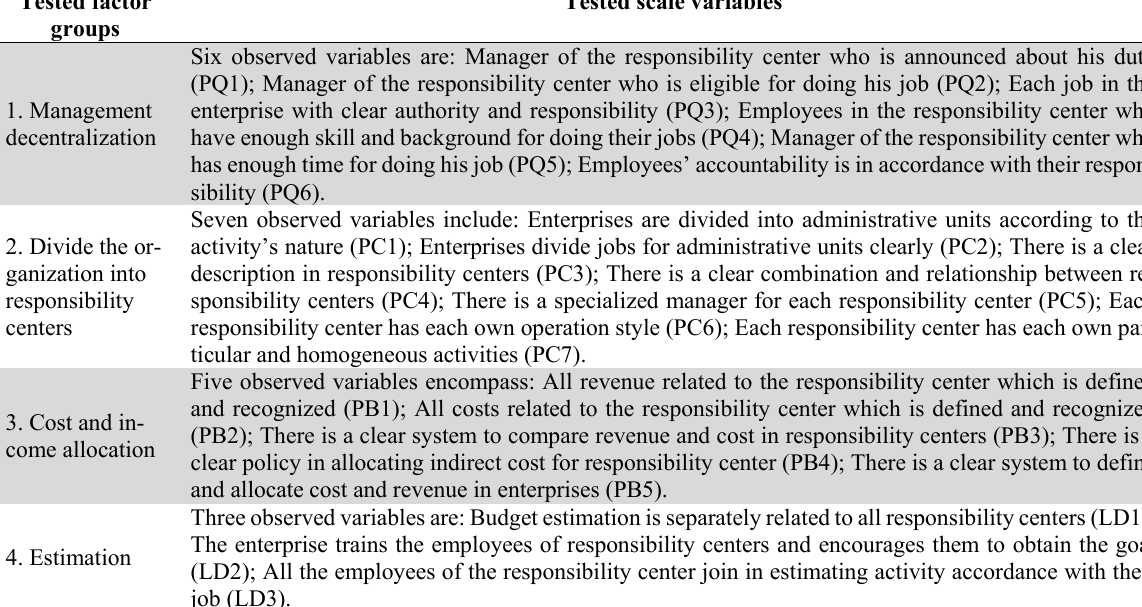
Tested factor groups and scale